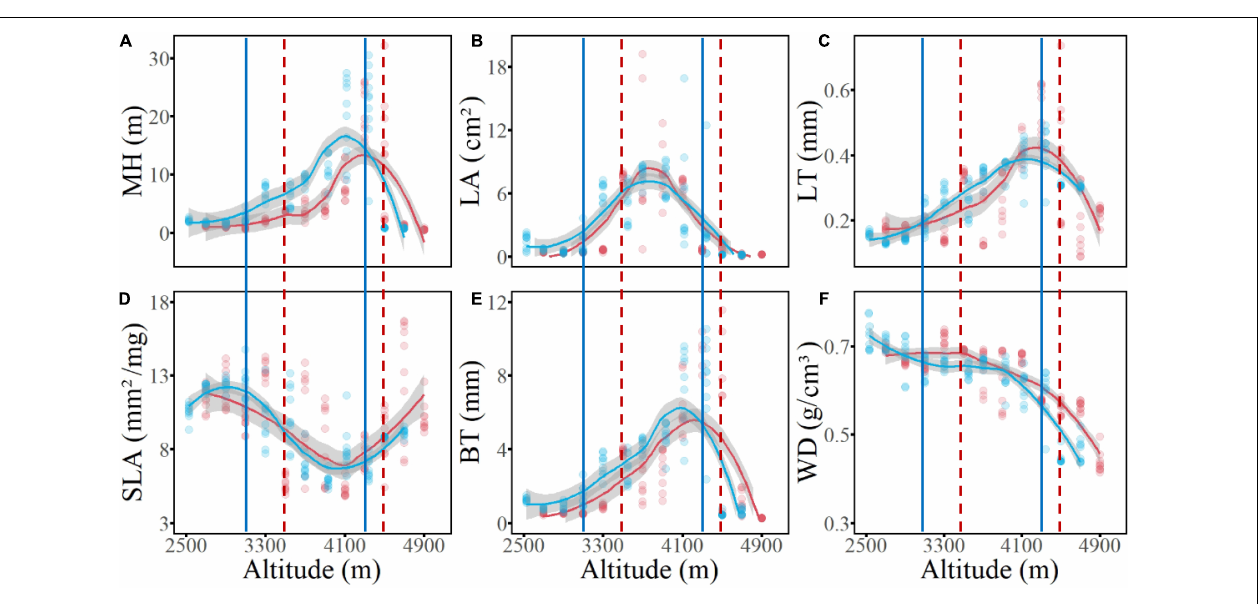
FIGURE 5 | The elevational patterns of abundance-weighted community mean values of six functional traits of woody plants on two slopes of Hongla Snow Mountain. Dots are plot values and lines represent theestimates of Lasso regression of transect value; Red indicates the west slope, blue indicates the east slope. (A) MH, maximum plant height; (B) LA, leaf area; (C) LT, leaf thickness; (D) SLA, specific leaf area; (E) BT, bark thickness; (F) WD, wood density. Vertical solid and dash lines represent lower and upper boundaries of the forest belt on thewest and east